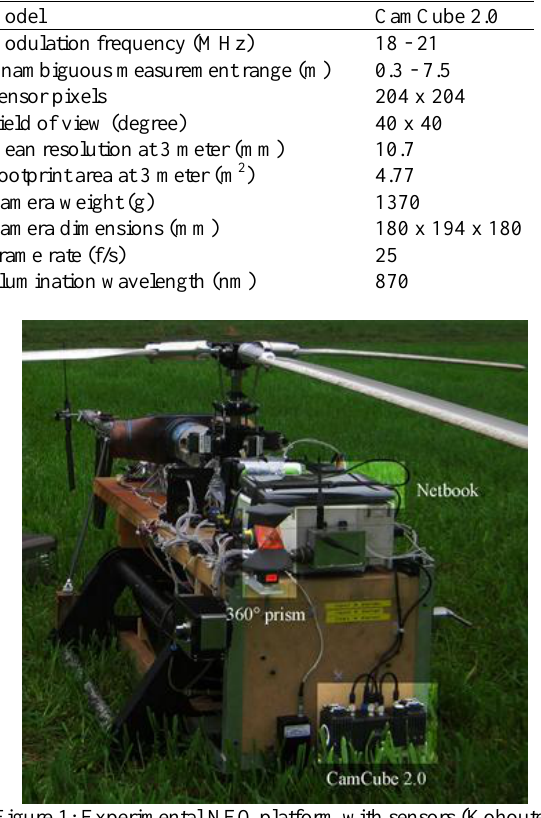
Figure 1: Experimental NEO platform with sensors (Kohoutek et al.